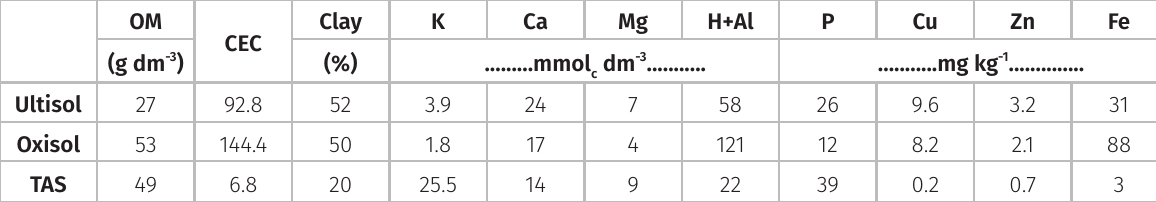
Table I. Physical and chemical parameters of the soils used in the ecotoxicology tests. OM CEC